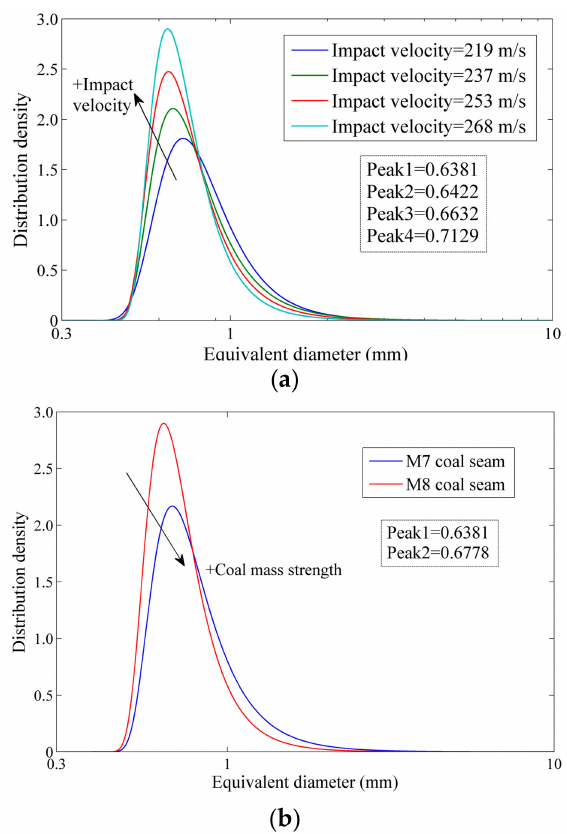
Figure 8. Distribution density of the equivalent diameter of coal fragments for various jet velocities and coal mass strengths. ( a ) Different jet velocities in the M8 coal seam. ( b ) Different strengths of coal seams at the same jet velocity of 268 m/s.